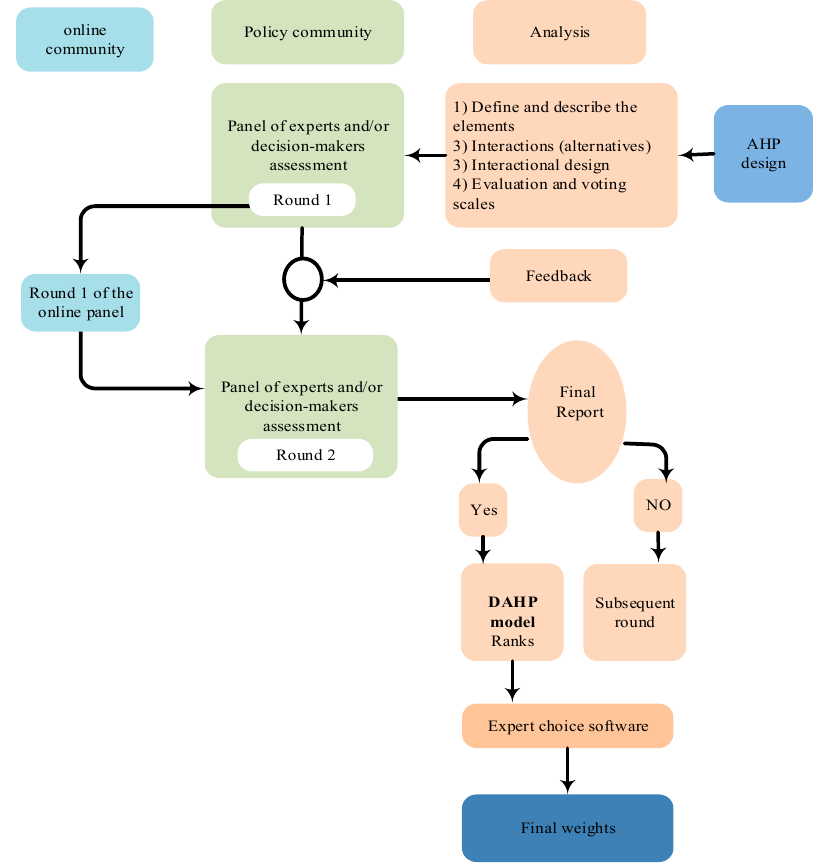
Figure 10. Hierarchy SUL model